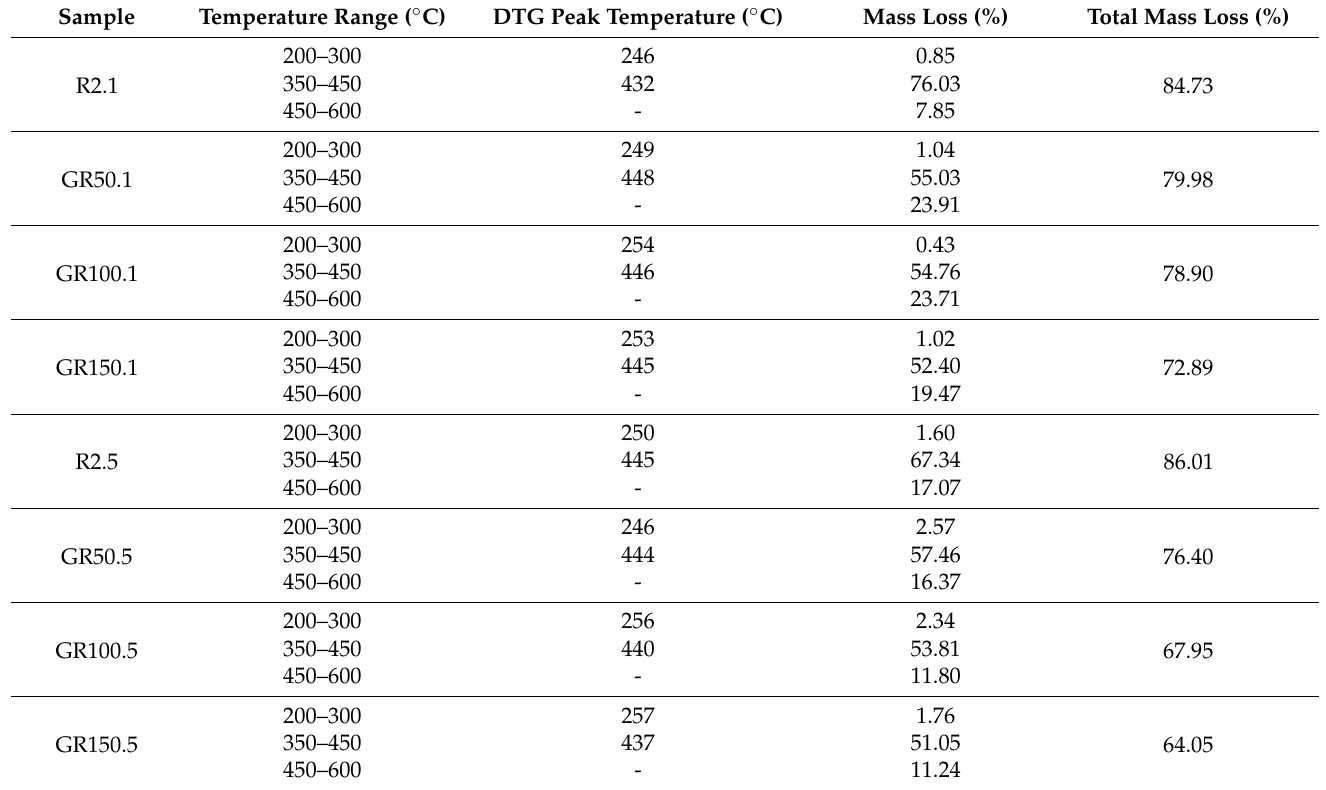
Table 6. TGA data of